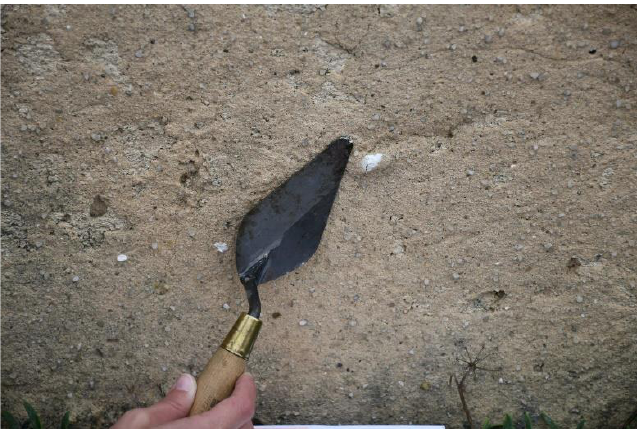
Figure 2. Lime lumps found in the renders of Paimogo’s Fort.